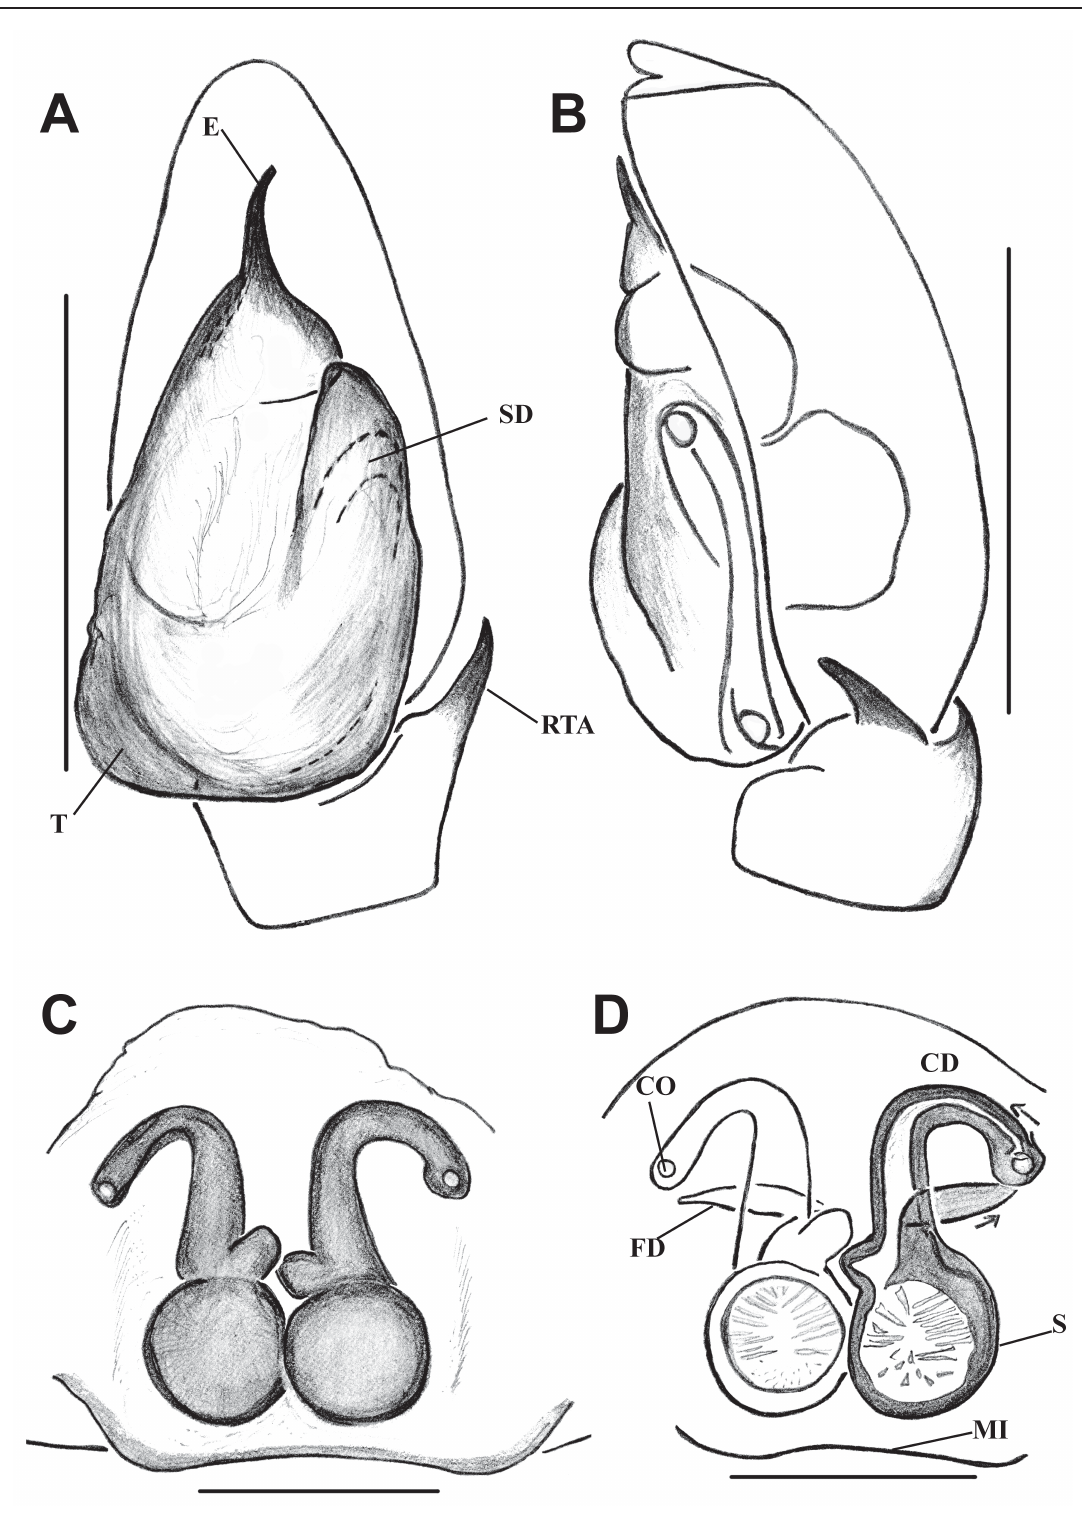
Fig. 4. Bristowia gandhii sp. nov. A–B . ♂ (IFS_SAL 228). C–D . ♀ (IFS_SAL 297). A . Palp, ventral view. B . Palp, retrolateral view. C . Epigynum, ventral view. D . Vulva, ventral view. Abbreviations: CD = copulatory duct; CO = copulatory opening; E = embolus; FD = fertilization duct; MI = median indentation; RTA = retrolateral tibial apophysis; S = spermathecae; SD = sperm duct; T = tegulum. Scale bars: A–B = 0.2 mm; C–D = 0.1